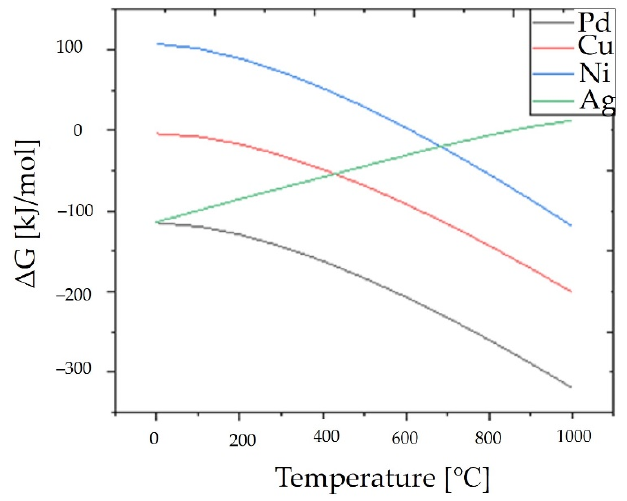
Figure 2. Thermochemical analysis of hydrogen reduction in Pd, Cu, Ni, and Ag.